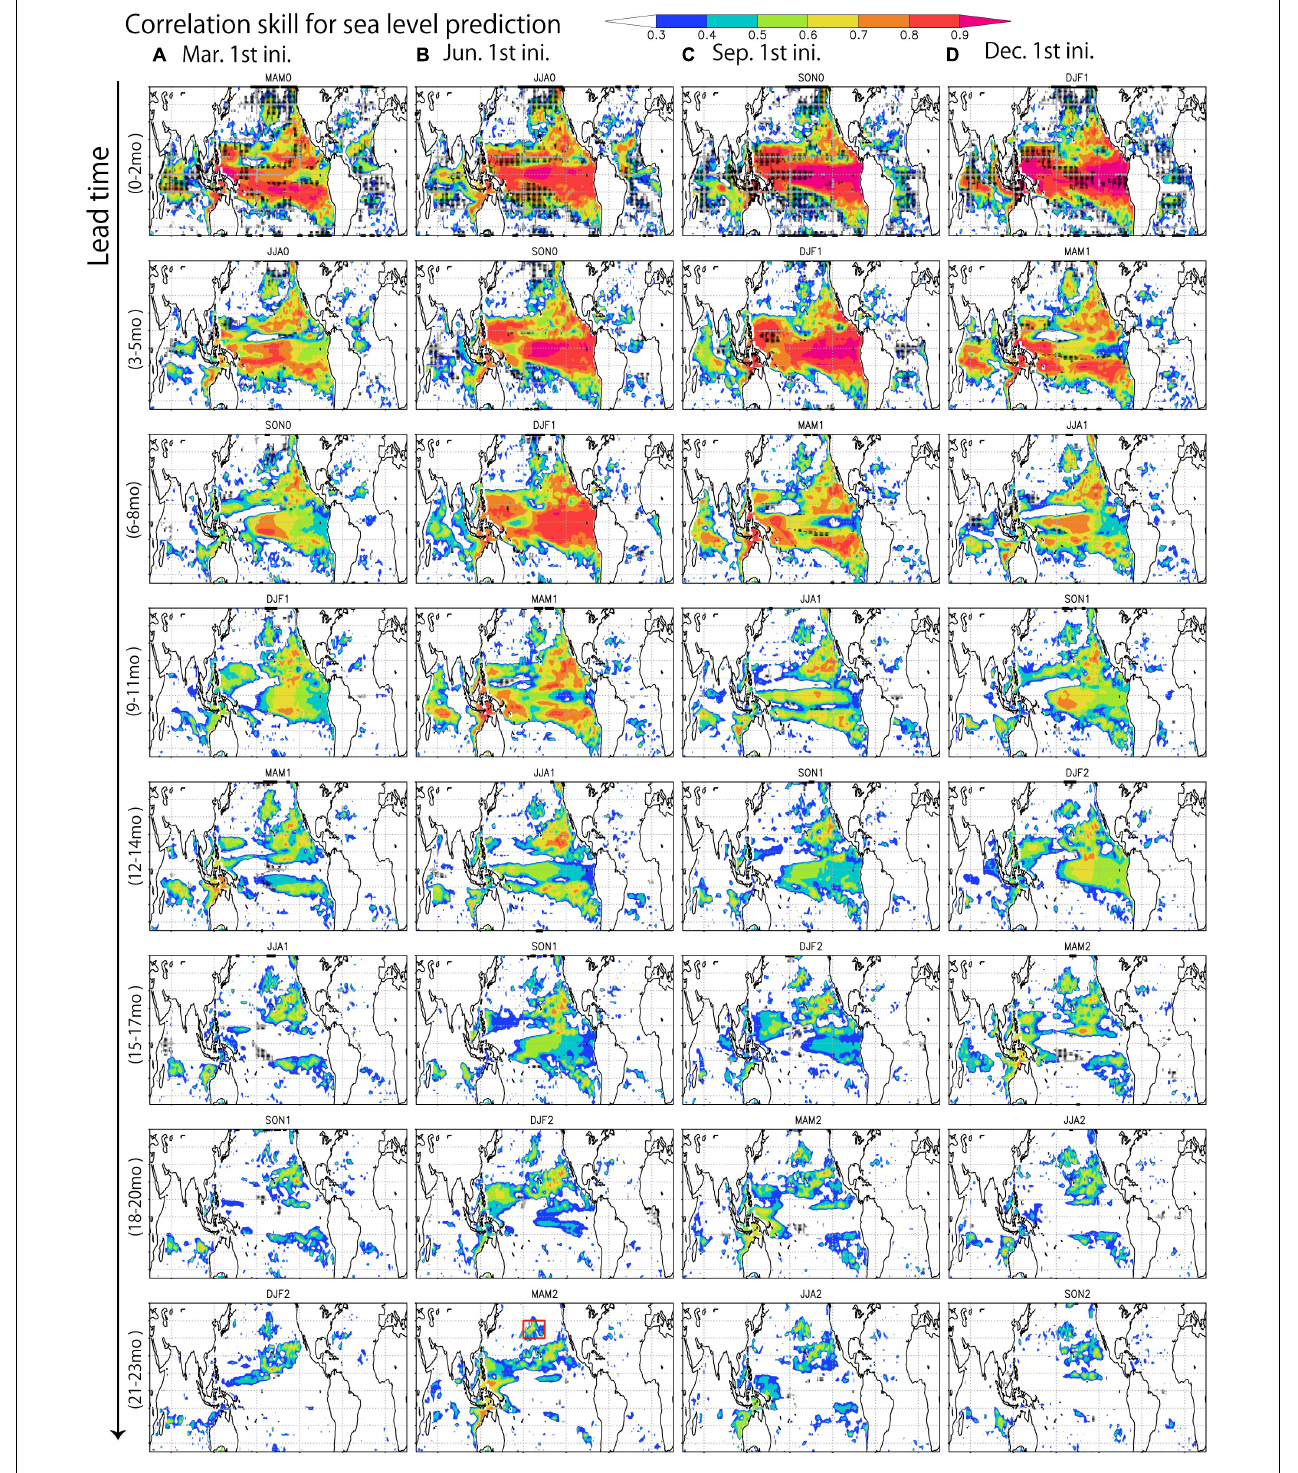
FIGURE 1 | (A) The correlation coefficient for seasonal-to-interannual prediction for sea level anomalies (ensemble mean) from the 0–2 months lead average up to the 21–23 months lead average issued on March 1, 1993–2018. Black dots indicate regions where the correlation is below the persistence (lag autocorrelation of observation). Considering that the degree of freedom based on the sample size, the correlation beyond 0.3 is statistically significant at a 90% level. So, the correlation greater than 0.3 is masked out. (B–D) Same as (A) , but for the prediction issued on June 1, September 1, and December 1. The target area in the North Pacific (30 ◦ –40 ◦ N, 180 ◦ –150 ◦ W) is shown by a red box in MAM2 prediction issued on June 1.